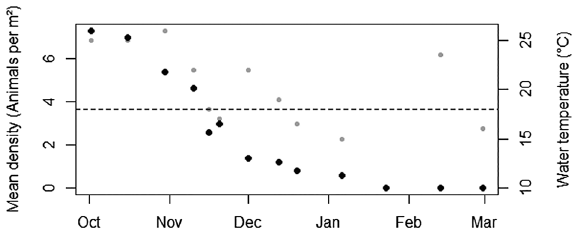
Figure 6. Field population density. Population densities of Cassiopea sp. at Lido Key, Florida, through the winter of 2019–2020. Density (black) declines throughout the season, and population decline coincides with low water temperatures (grey). Horizontal dashed line indicates 18 °C water